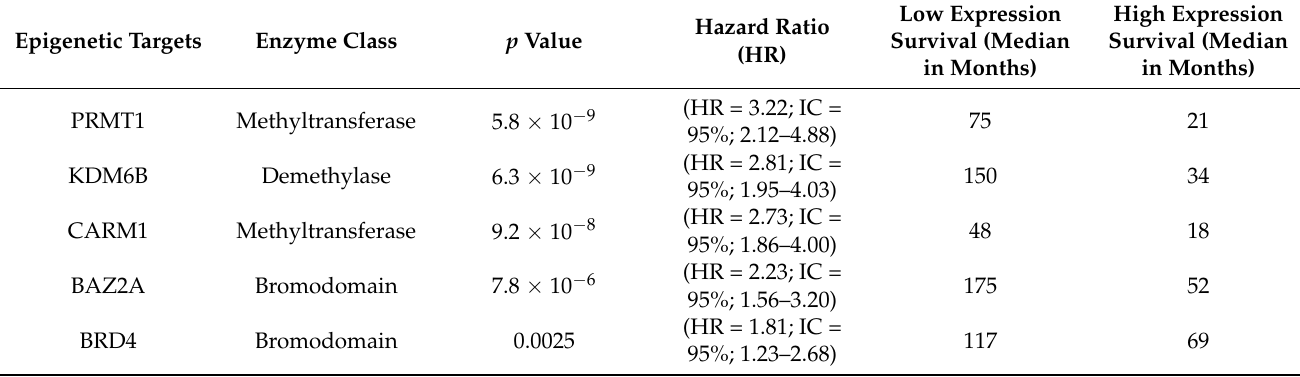
Table 1. The eight significant potential epigenetic targets selected by inverse association with survival rates of patients diagnosed with pulmonary adenocarcinoma. The survival medians of the low and high expression groups of the targets were also